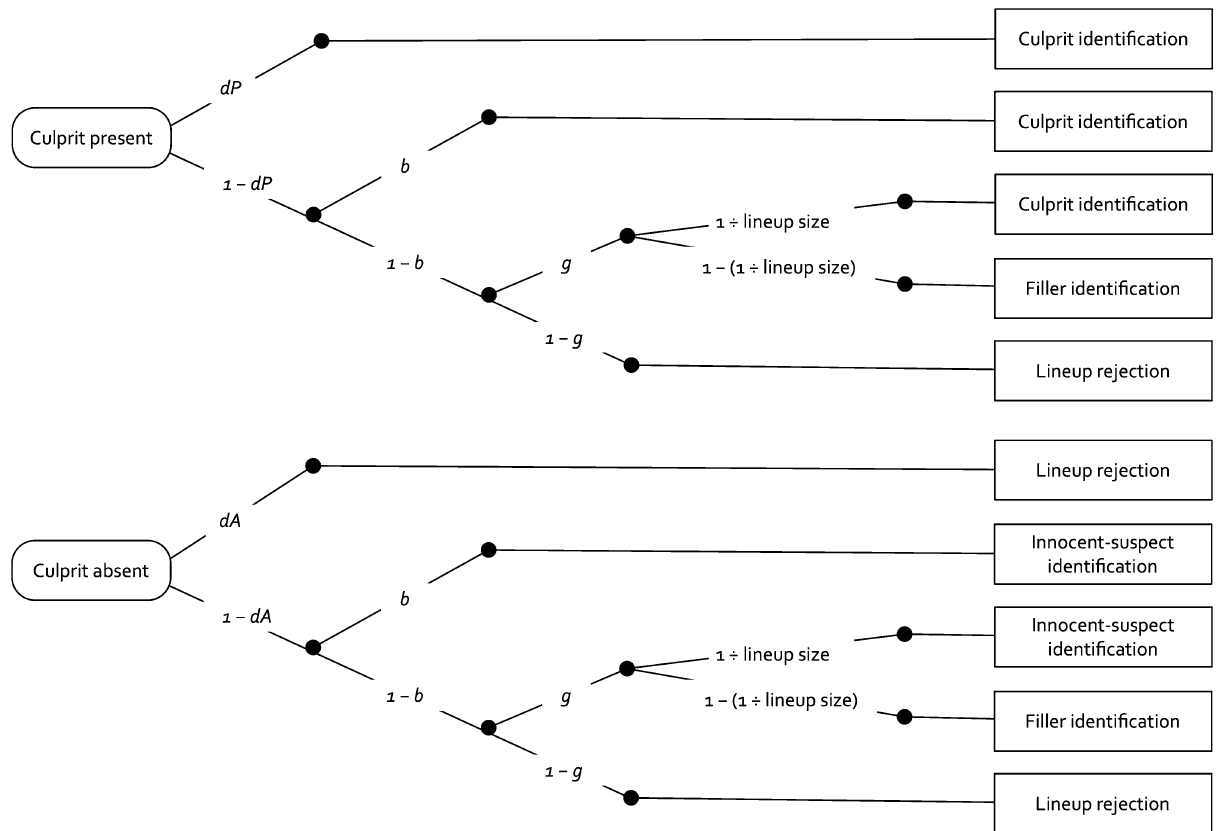
Figure 1. Graphical illustration of the 2-HT eyewitness identification model. The rounded rectangles on the left represent lineups in which the culprit is either present or absent. The rectangles on the right represent the possible responses of an eyewitness in a culprit-present or a culprit-absent lineup. The letters attached to the branches represent the probabilities of the latent cognitive processes postulated by the model that lead to the responses of the eyewitness ( dP : detection of the presence of the culprit; b : biased selection of a suspect who stands out from the fillers; g : guessing-based selection among the lineup members; dA: detection of the absence of the culprit). The lineup size is a known constant: the number of persons in the